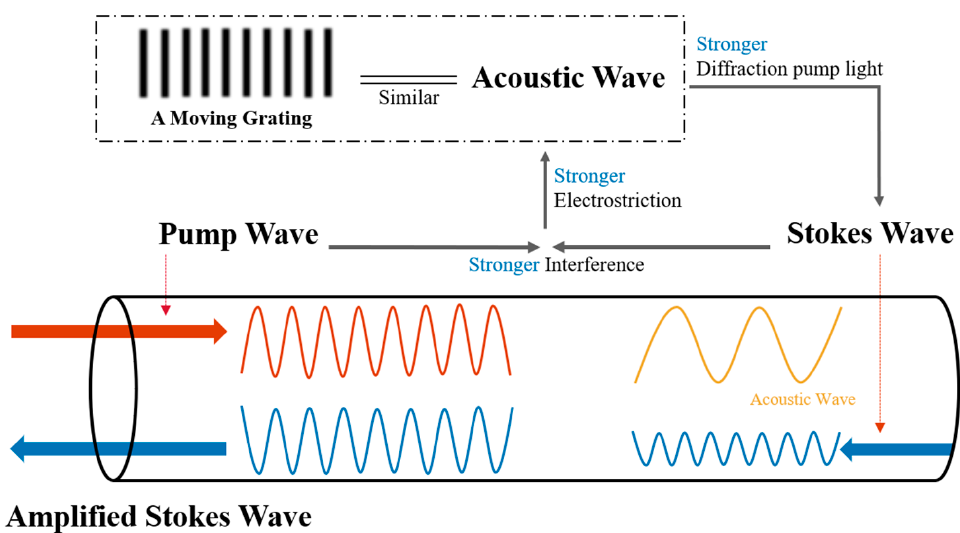
Figure 4. SBS schematic diagram.